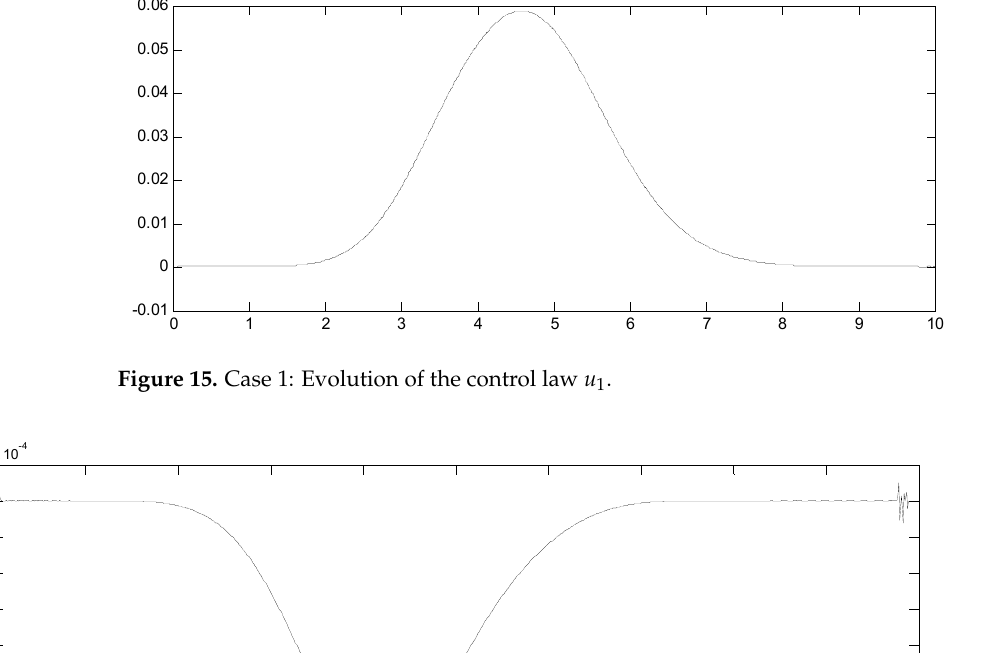
Figure 14. Case 1: Evolution of the trajectory of the robot in the Cartesian coordinate system.